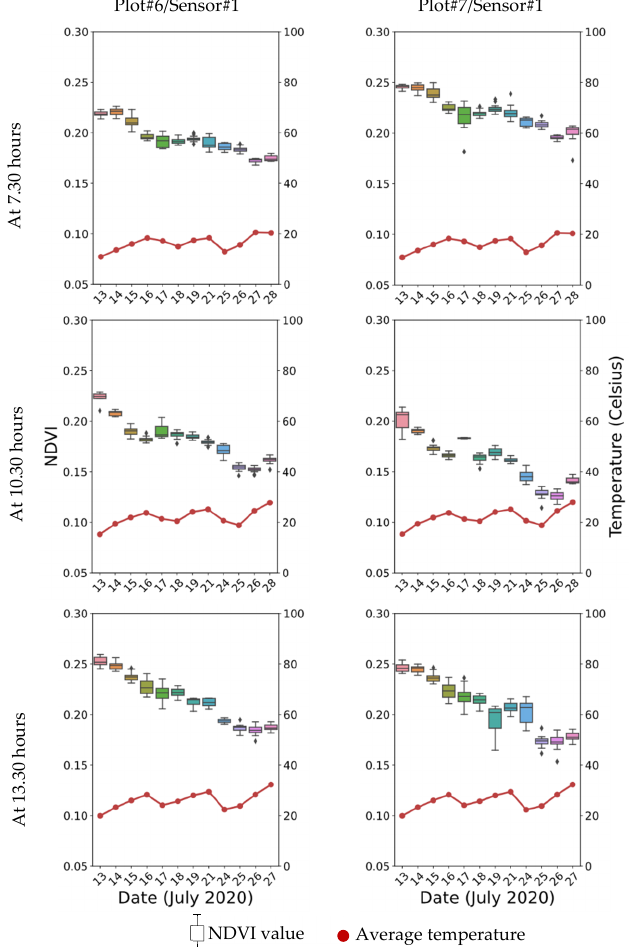
Figure 7. Box plot of average NDVI data during the data acquisition period at different time points with temperature data from two representative plots.